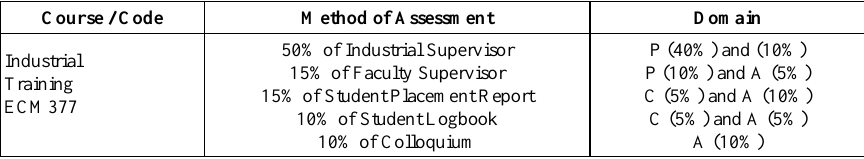
Table 2. The assessment method for the